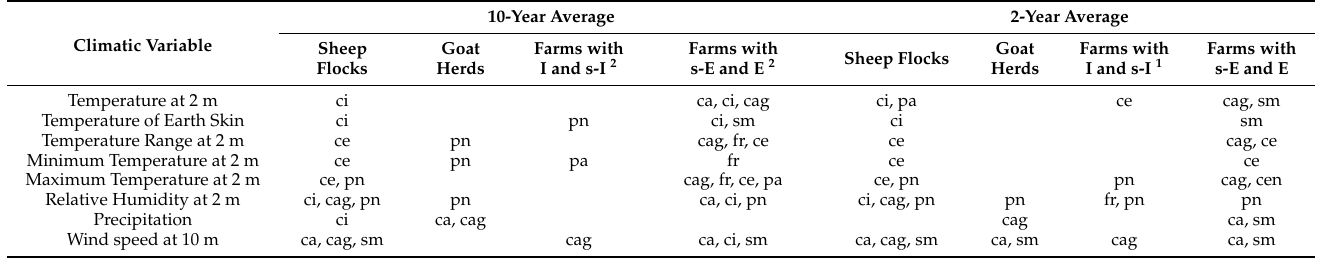
Table 2. Cumulative findings of the multivariable analysis of climate conditions for associations with optional vaccination against eight infections 1 in 444 small ruminant farms in